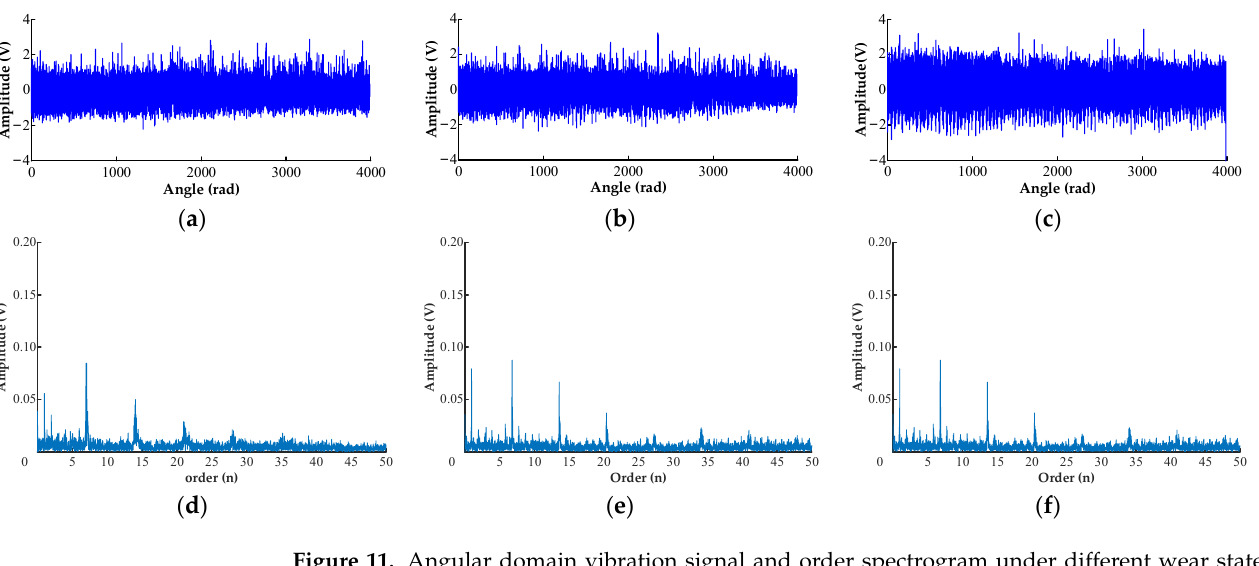
spectrogram in mild state; ( f ) Order spectrogram in moderate